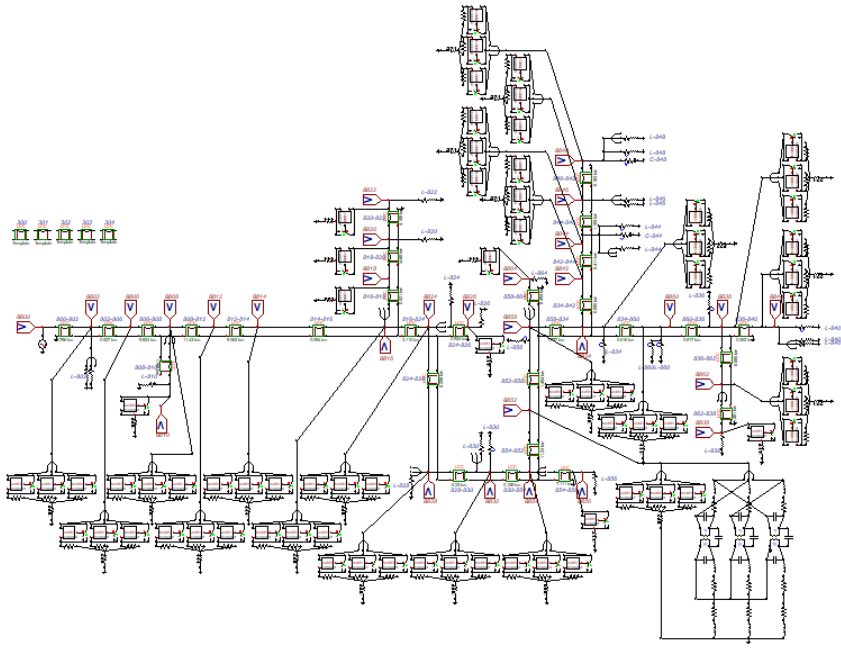
Figure 11. IEEE 34 bus test feeder modeled in ATP